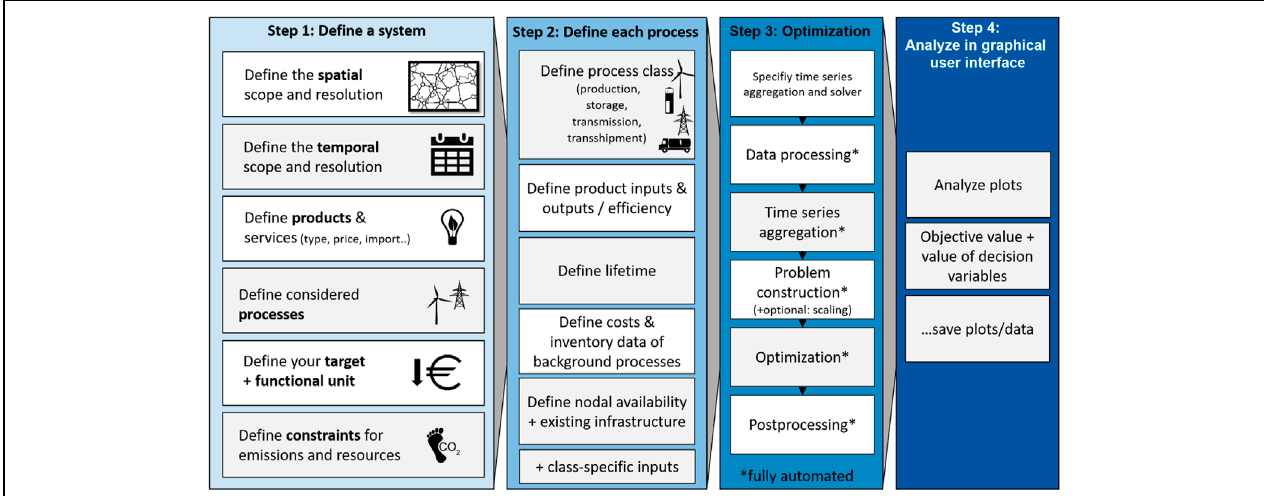
FIGURE 1 | Flowsheet of the SecMOD framework: First, the user needs to define a system. Second, the user needs to define processes used in the system. Third, the optimization is run. Last, the user can analyze the results in a graphical user